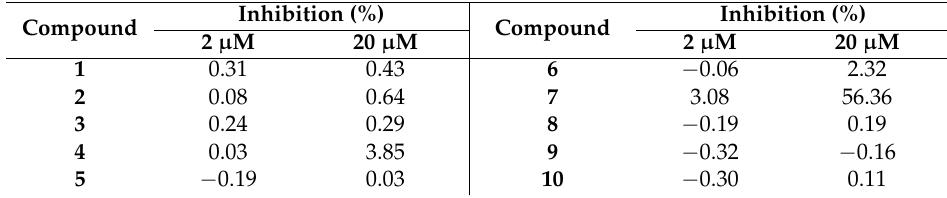
Table 3. Functional inhibition of P-gp by compounds 1 – 10 .